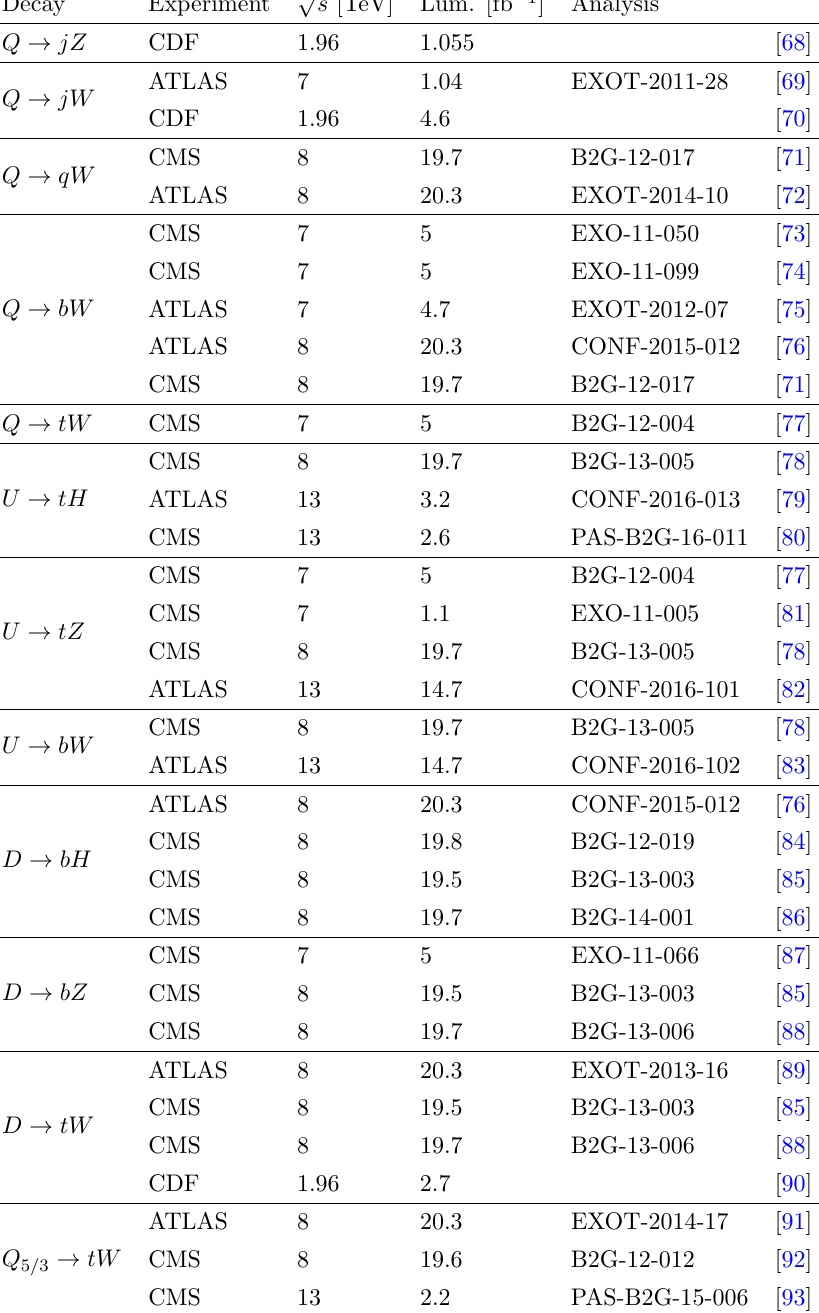
Table 1 . Experimental analyses included in our numerics for heavy quark partner decay. Q stands for any quark partner where the decay in question is allowed by electric charges, j stands for a light quark or b jet, and q for a light quark